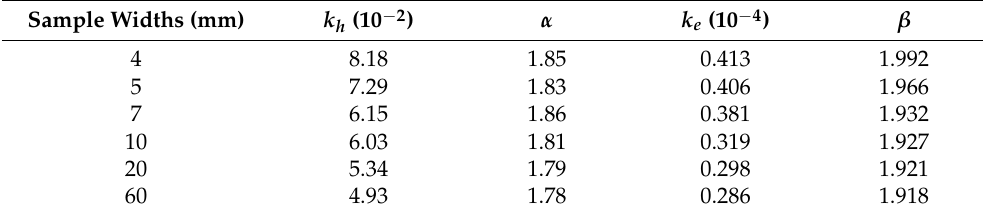
Table 3. Coefficients k h , k e , α , and β approximating the specific loss characteristics of electrical steel sheets M270-35A as a function of the width of the sample cut with a guillotine for the frequency ≥ 4000 Hz and the induction range up to 0.3 T.